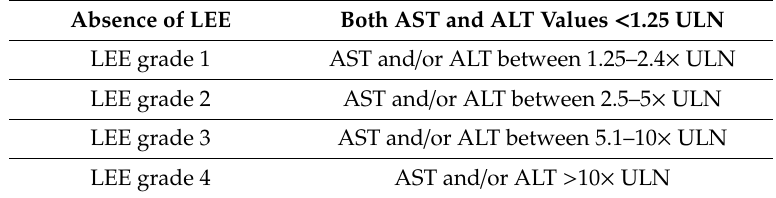
Table 1. Definition of liver enzyme elevation (LEE). Patients were classified based on changes relative to the upper limit of normal (ULN) of the reference laboratory, i.e., 40 U / L for both AST and ALT. Absence of LEE Both AST and ALT Values < 1.25 ULN LEE grade 1 AST and / or ALT between 1.25–2.4 × ULN LEE grade 2 AST and / or ALT between 2.5–5 × ULN LEE grade 3 AST and / or ALT between 5.1–10 × ULN LEE grade 4 AST and / or ALT > 10 × ULN AST: aspartate aminotransferase; ALT: alanine aminotransferase; ULN: upper limit of